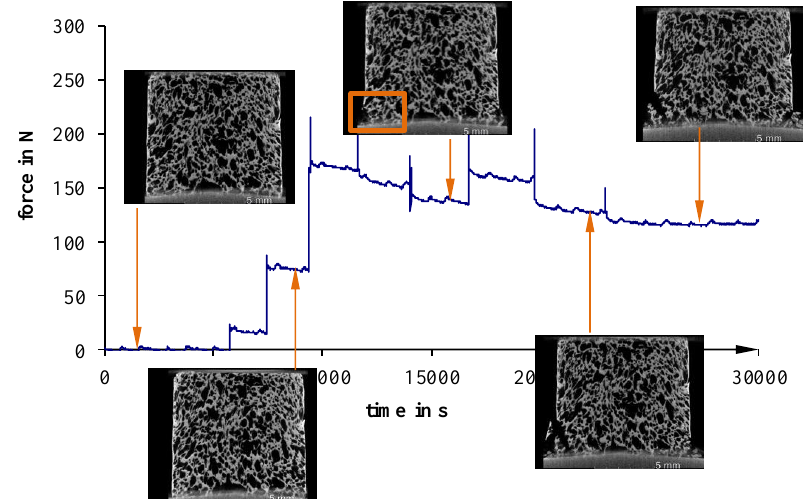
Figure 11. Recorded force–travel curves of compression tests conducted on an in situ µCT; 5 °C.